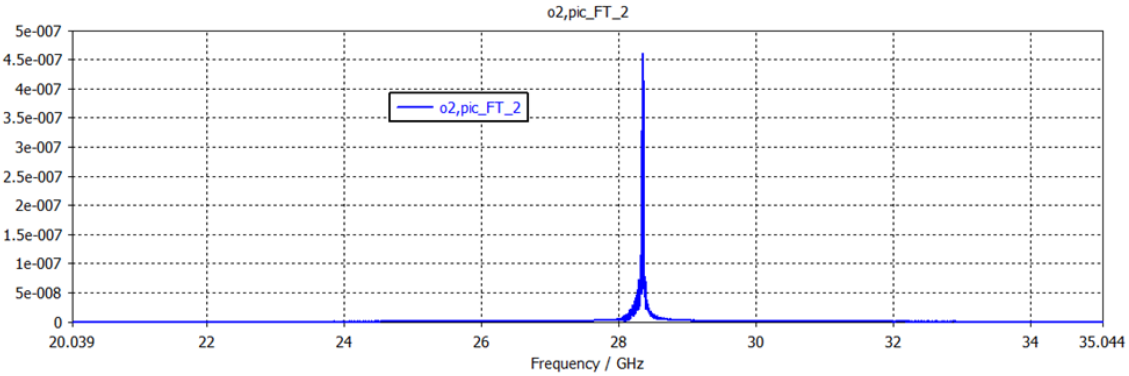
Figure 16. Input port signal of RF section.